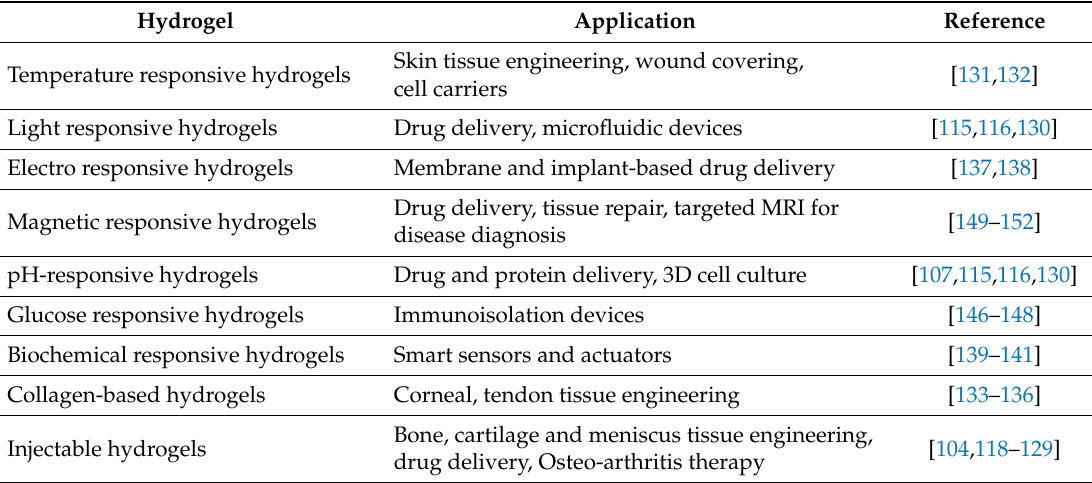
Table 1. Overview of hydrogels and their applications Hydrogel Application